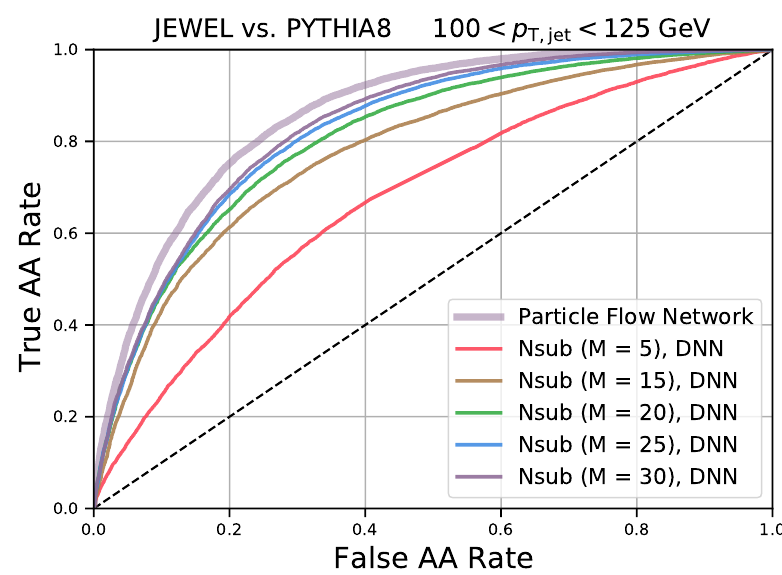
Figure 4 . ROC curves for jets in pp vs. AA collisions using the N -subjettiness basis. For compar- ison we also show the result obtained using the classifier based on